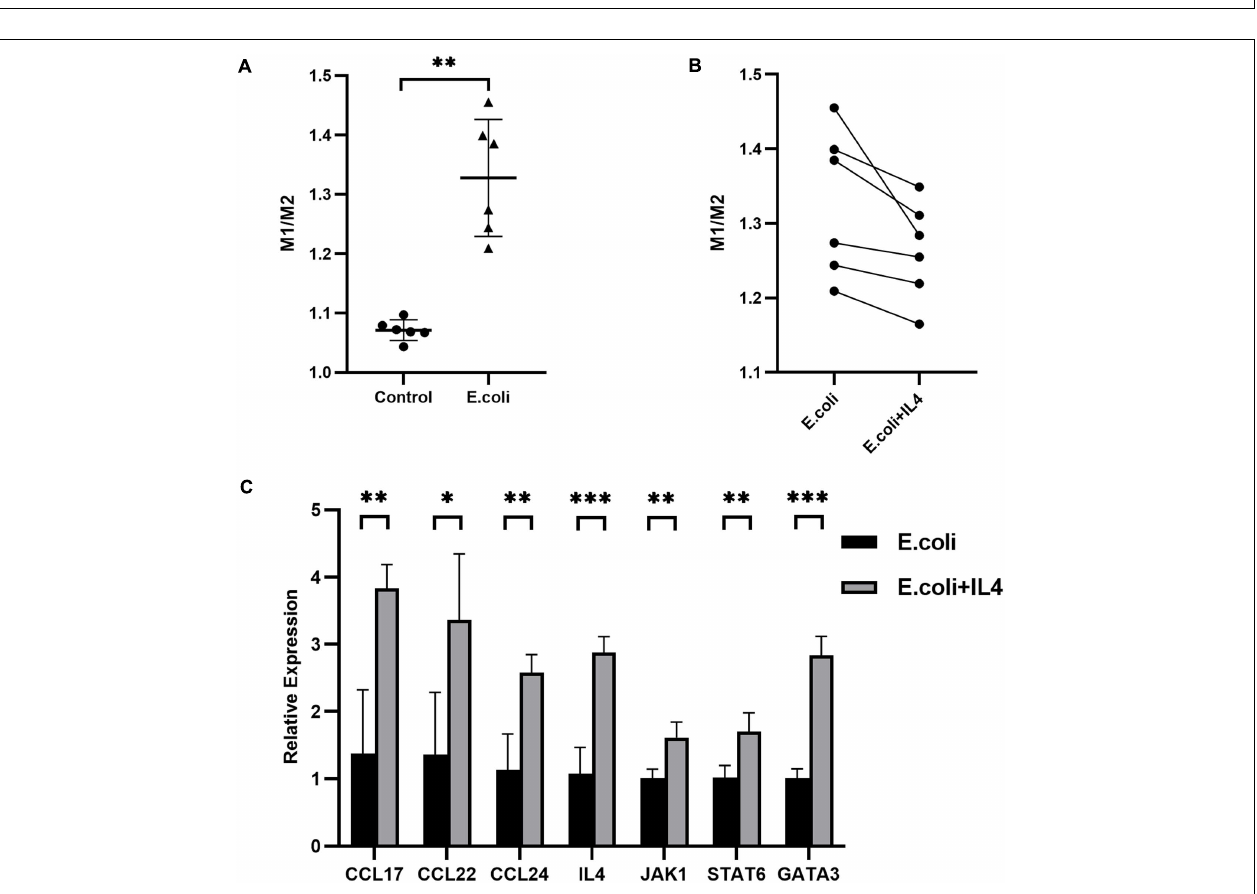
FIGURE 6 | Primary decidual macrophages extracted from the maternal-fetal interface in mice. (A) Ratio of M1 to M2 macrophages extracted from the maternal-fetal interface between the study ( E. coli ) group and control group ( n = 6). (B) Ratio of M1 to M2 macrophages before and after addition of IL-4 to macrophages extracted from the maternal-fetal interface in the study group ( n = 6). (C) Relative expression of the IL-4/JAK-1/STAT-6 pathway in primary decidual macrophages extracted from the maternal-fetal interface at E11.5. Four samples of each group were used. The experiment was performed in triplicate wells and repeated two times. Data are shown as mean ± standard deviation. Unpaired t -test was used for two-group comparisons. ∗ P < 0.05, ∗∗ P < 0.01, ∗∗∗ P < 0.001.